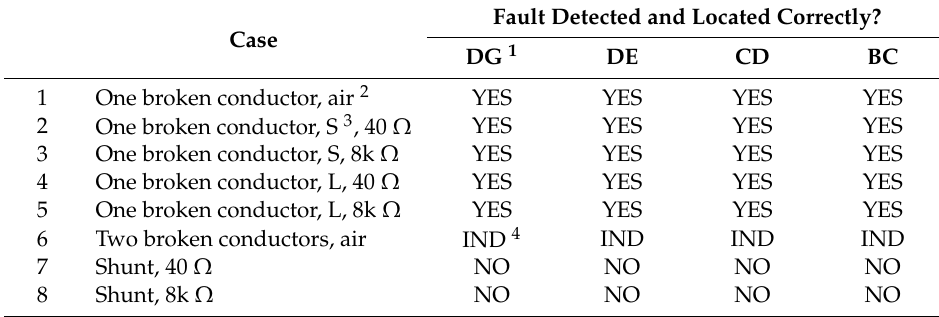
Table 9. Summary of HIF detection and